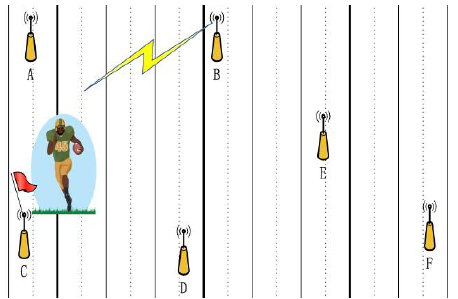
Figure 1. Sketch map of footwork